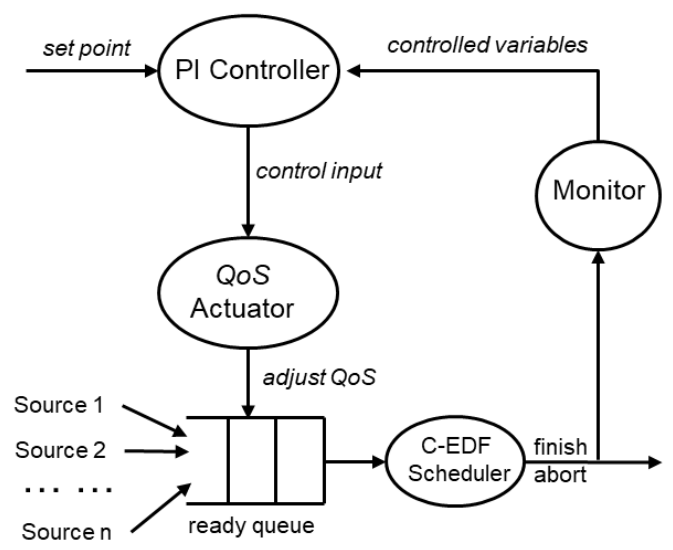
Figure 4. QoS-EML Figure 4. QoS-EML Simulator.